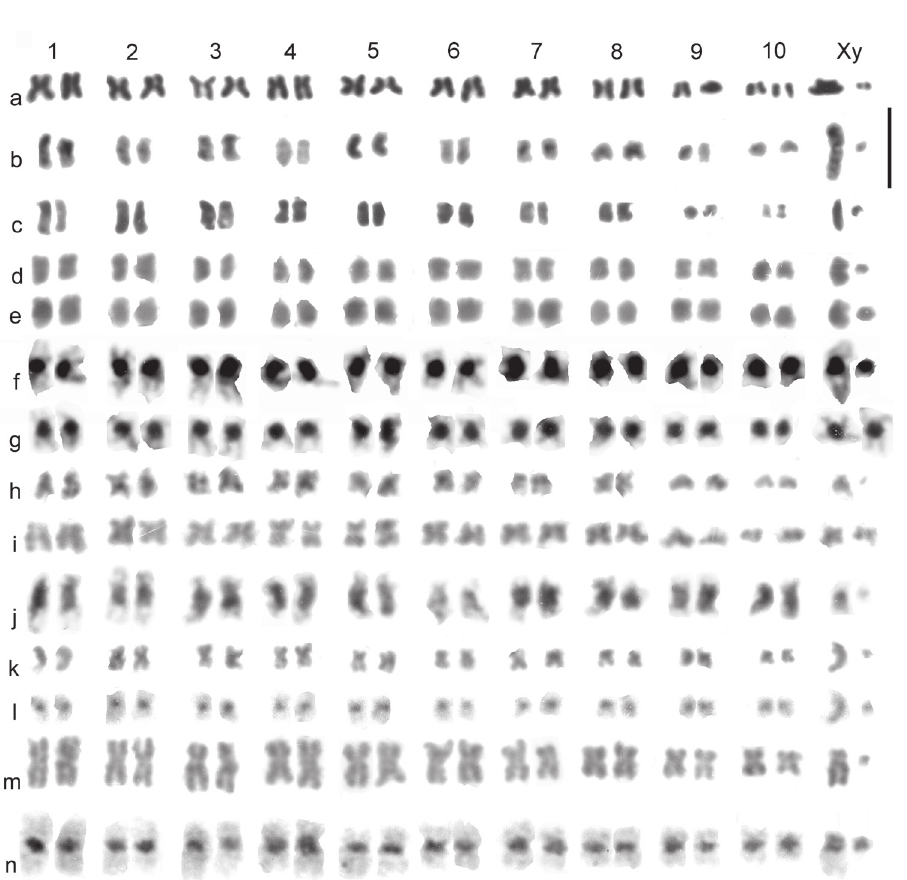
Figure 2. Mitotic chromosomes of Leiodidae, arranged as karyotypes: a , b Catops coracinus , unbanded a mid-gut b testis c Leiodes calcarata , testis d – g Cantabrogeus luquei , mid-gut d , e ♂ unbanded f ♂ C-banded g ♀ C-banded h , i Espanoliella luquei , mid-gut, unbanded h ♂ i ♀ j Fresnedaella lucius , testis, C-banded k , l Notidocharis uhagoni , ♂ , mid-gut k unbanded l the same nucleus C-banded m , n Quaestus pasensis , mid gut m unbanded n the same nucleus C-banded. Scale bar = 5